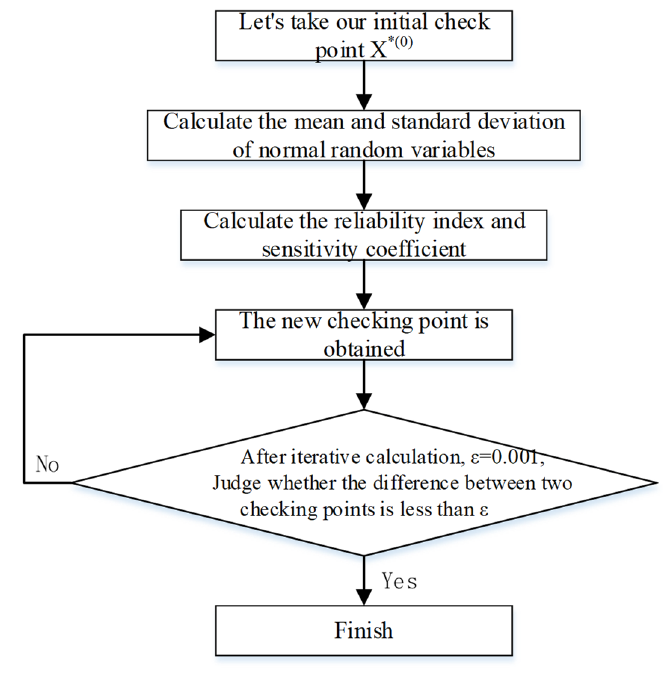
Figure 2. Calculation flow of the checking point method.